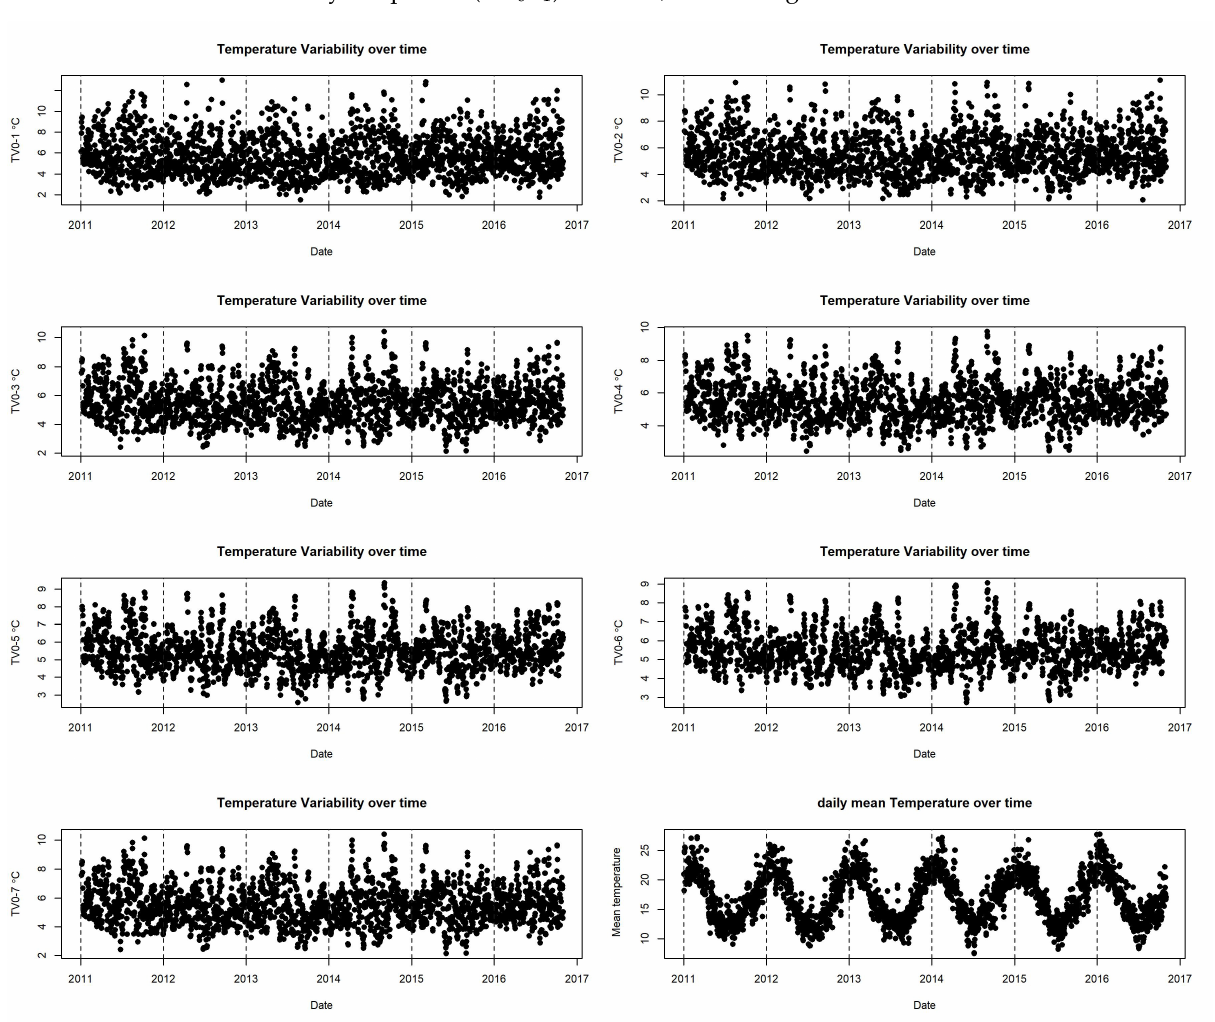
Figure 2. Time series of temperature and temperature variability over different exposure